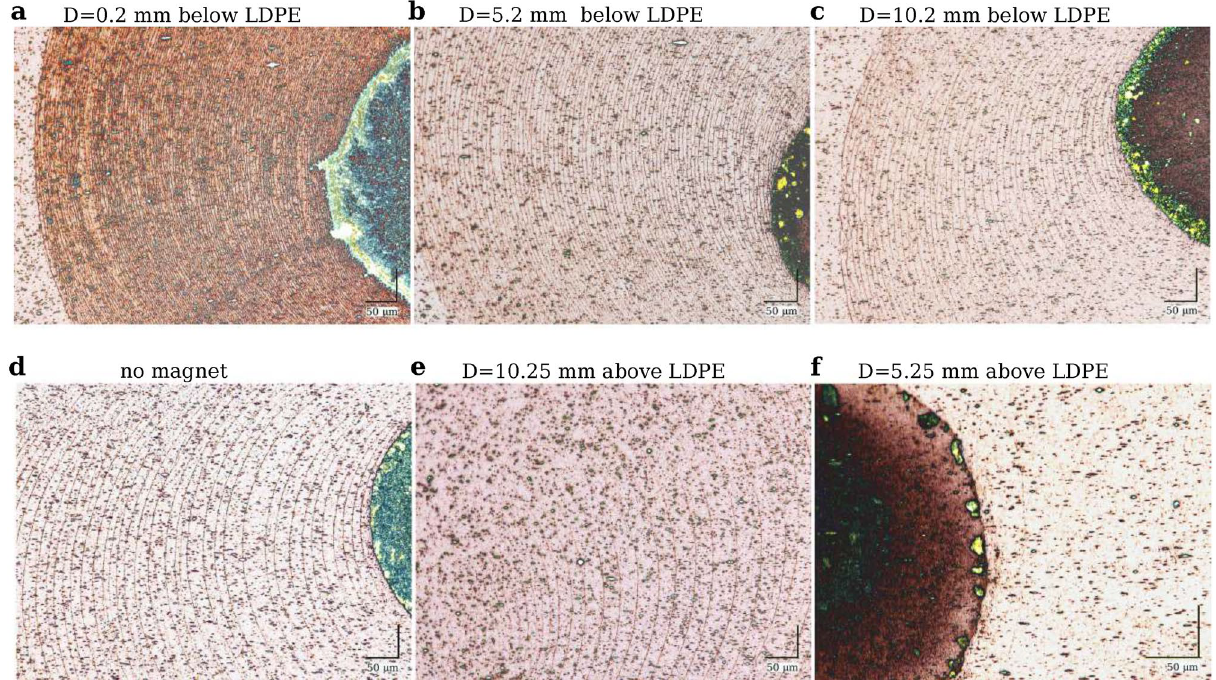
Figure 3. Optical microscope images of the stains from magnetic liquid droplets dried on the stretched LDPE film in the presence of the magnetic field gradient. The cylindrical neodymium magnet with the residual magnetic flux density B r 1T was used. Different distances D of the magnet from the LDPE film, on which ≈ the drying droplet was placed, make it possible to control the concentration of magnetic nanoparticles in the lower part of the droplet as a result of their movement in a magnetic field gradient towards the magnet. ( a ) D 0.2 mm below the film. ( b ) D 5.2 mm below the film. ( c ) D 10.2 mm below the film. ( d ) No magnet. = = = 10.25 mm above the film. ( f ) D 5.25 mm above the film. The optical visualization of the magnetic ( e ) D = = nanoparticle rings is due to the light scattering effect. Numerous dark spots outside the ring structures result from the light scattering on interior LDPE film